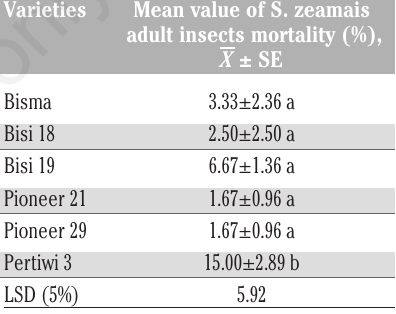
Table 2. Mean value of S. zeamais adult insects mortality (%) on six corn varieties using